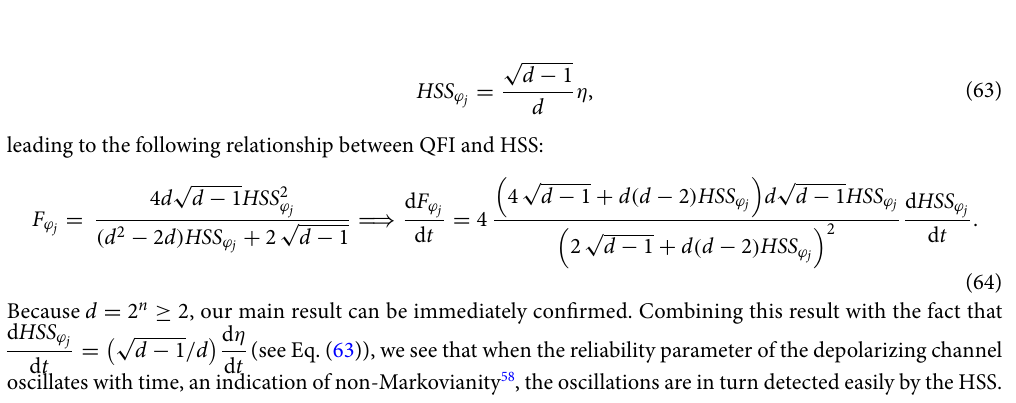
Figure 9. Illustration of an n -qubit register subject to the action of a common dephasing channel. This channel turns an initial pure GHZ state using Keynote, version 10.3.9 (7029.9.8), URL: https:// apps. apple. com/ it/ app/ keyno te/ id409 183694? mt=